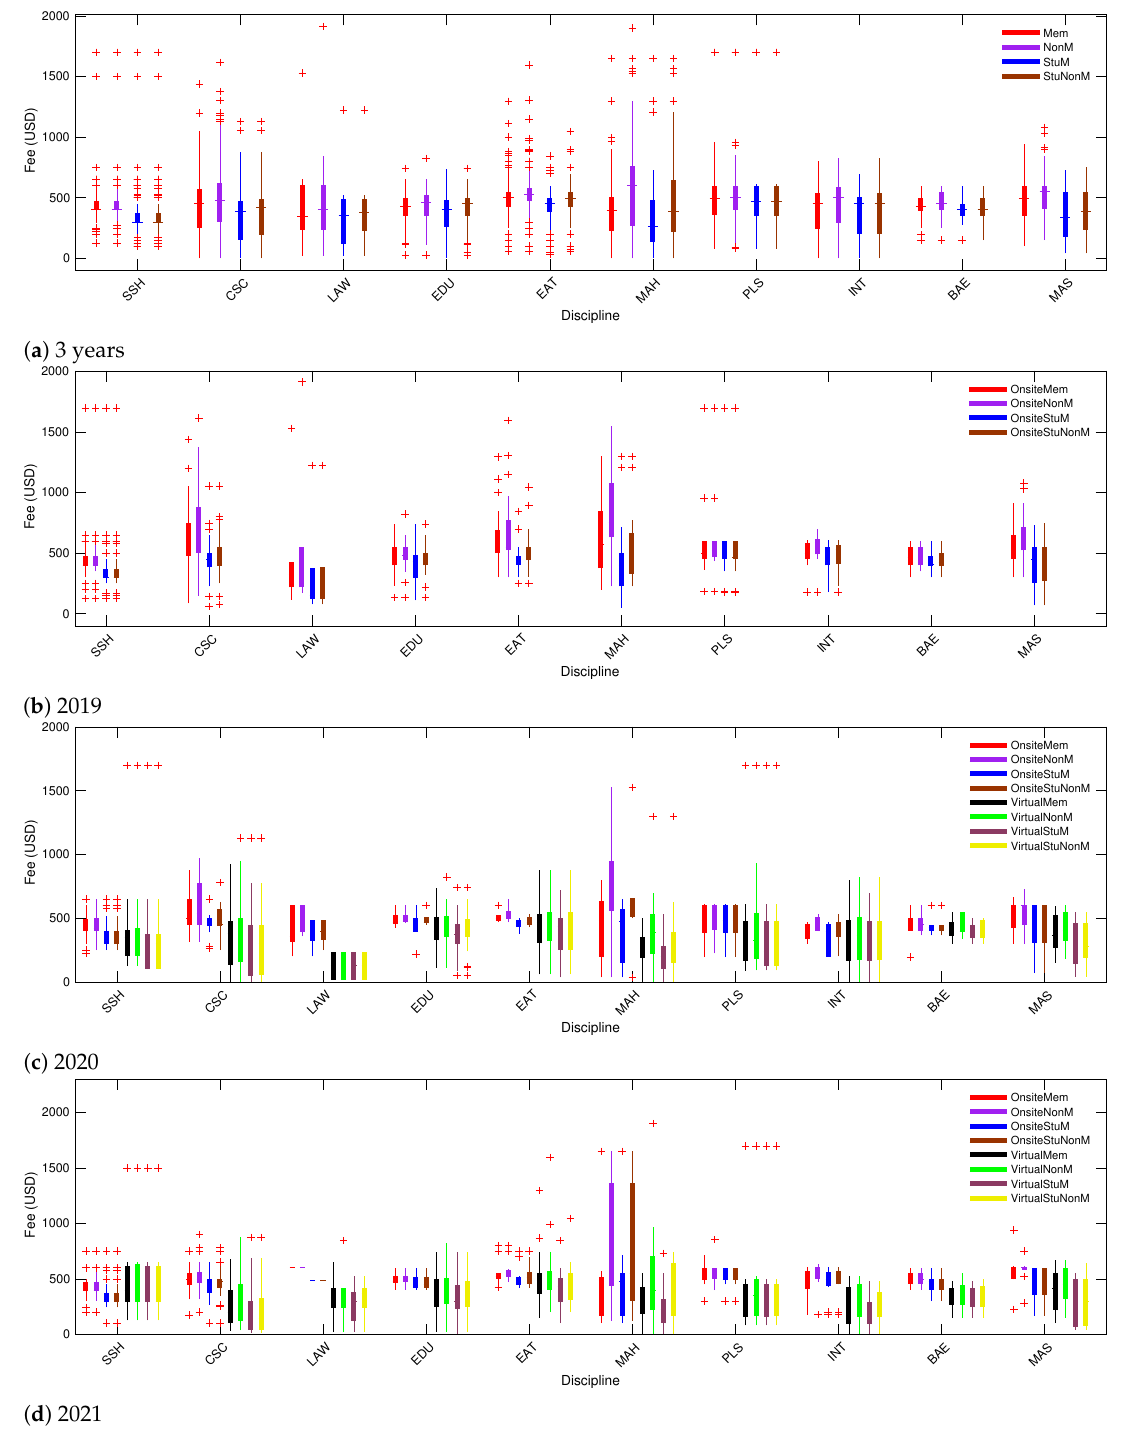
Figure A5. Boxplot of conference registration fees by disciplines. ( a ) Distribution for the three years. ( b – d ) Distribution for 2019, 2020, 2021,